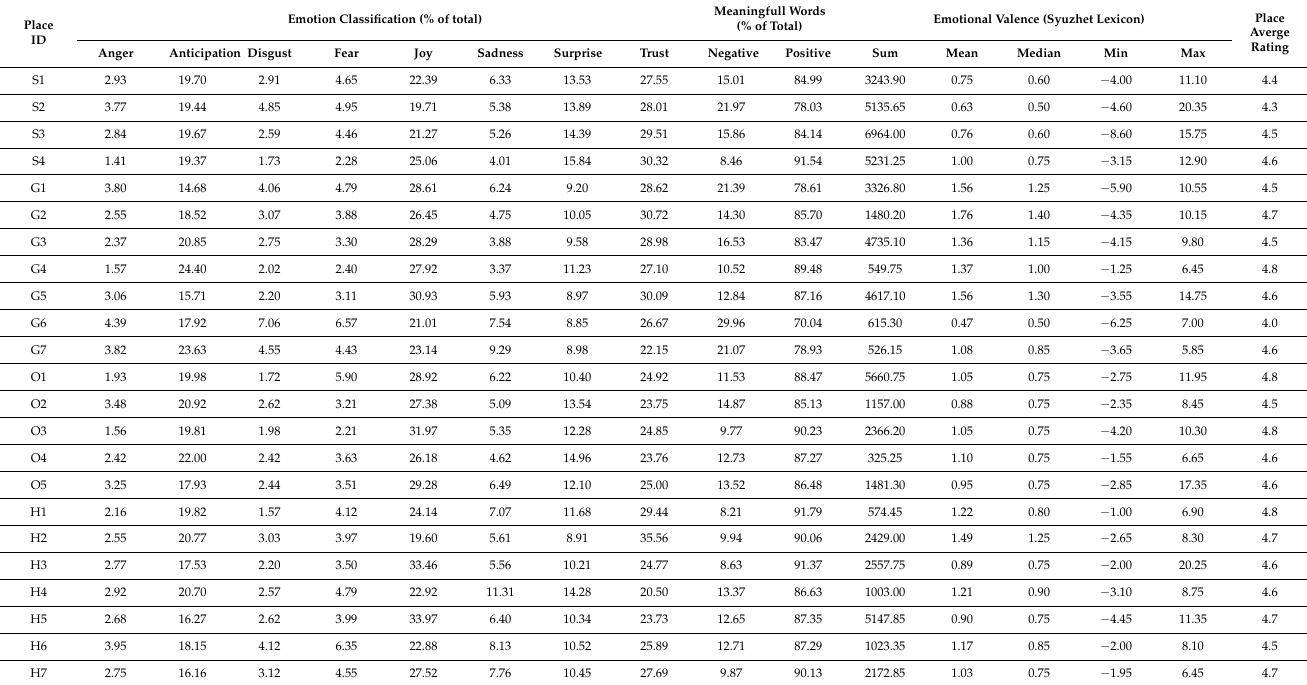
Table 8. Sentiment analysis and emotion classification of online